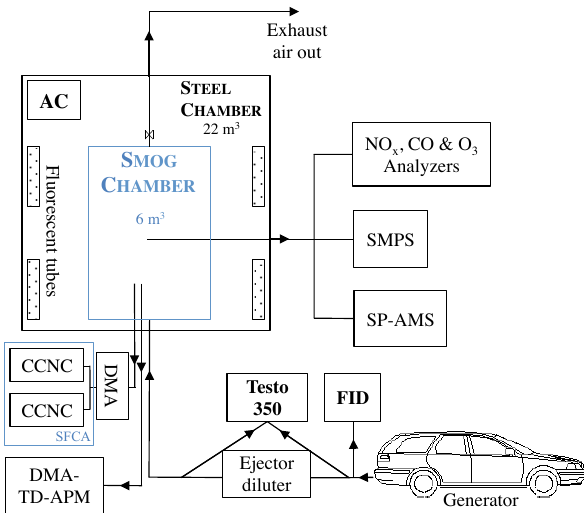
Figure 1. Schematic illustration of the instrumental set-up. Two sources of particles were examined: soot from (1) a Euro II Diesel Passenger Vehicle and (2) a Flame Soot Generator. The photochem- ical ageing was induced using black lights (peak at 354nm) in a 6m 3 Teflon/FEP bag inside the steel chamber. Two cloud conden- sation nucleus counters (CCNCs, DMT 100), running in parallel in SFCA operational mode, measured the cloud-activation proper- ties (for all experiments except DEP1). The Aerosol Particle Mass Analyzer (APM, Kanomax Japan 3600) characterised the parti- cle mass–mobility relationship. Both instruments measured the ex- haust aerosol after mobility size selection by a differential mobility analyser (DMA). A scanning mobility particle sizer (SMPS) sys- tem monitored the particle number size distribution. The chemical composition of the particles was determined using a Soot Particle Aerosol Mass Spectrometer (SP-AMS, Aerodyne